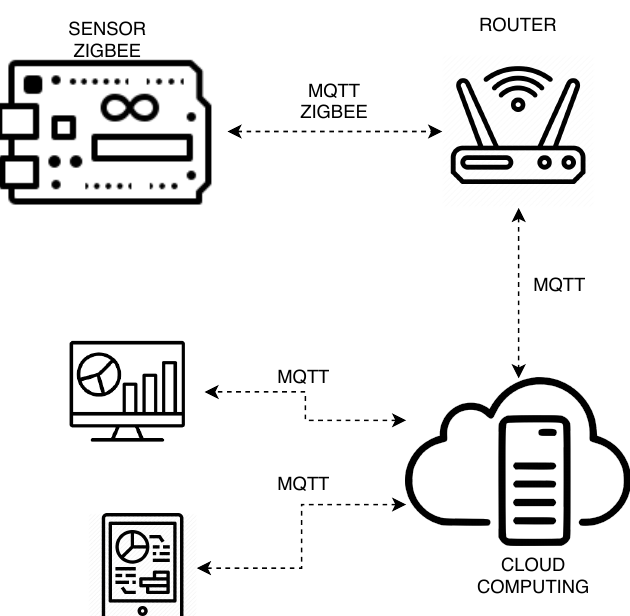
Figure 6. Communication between sensors and cloud